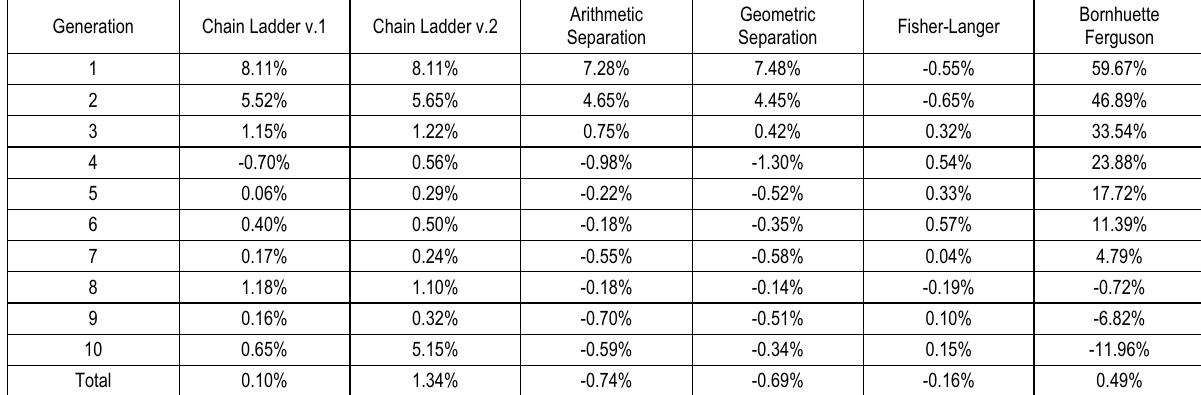
Table 12. Mean percentage error method of single